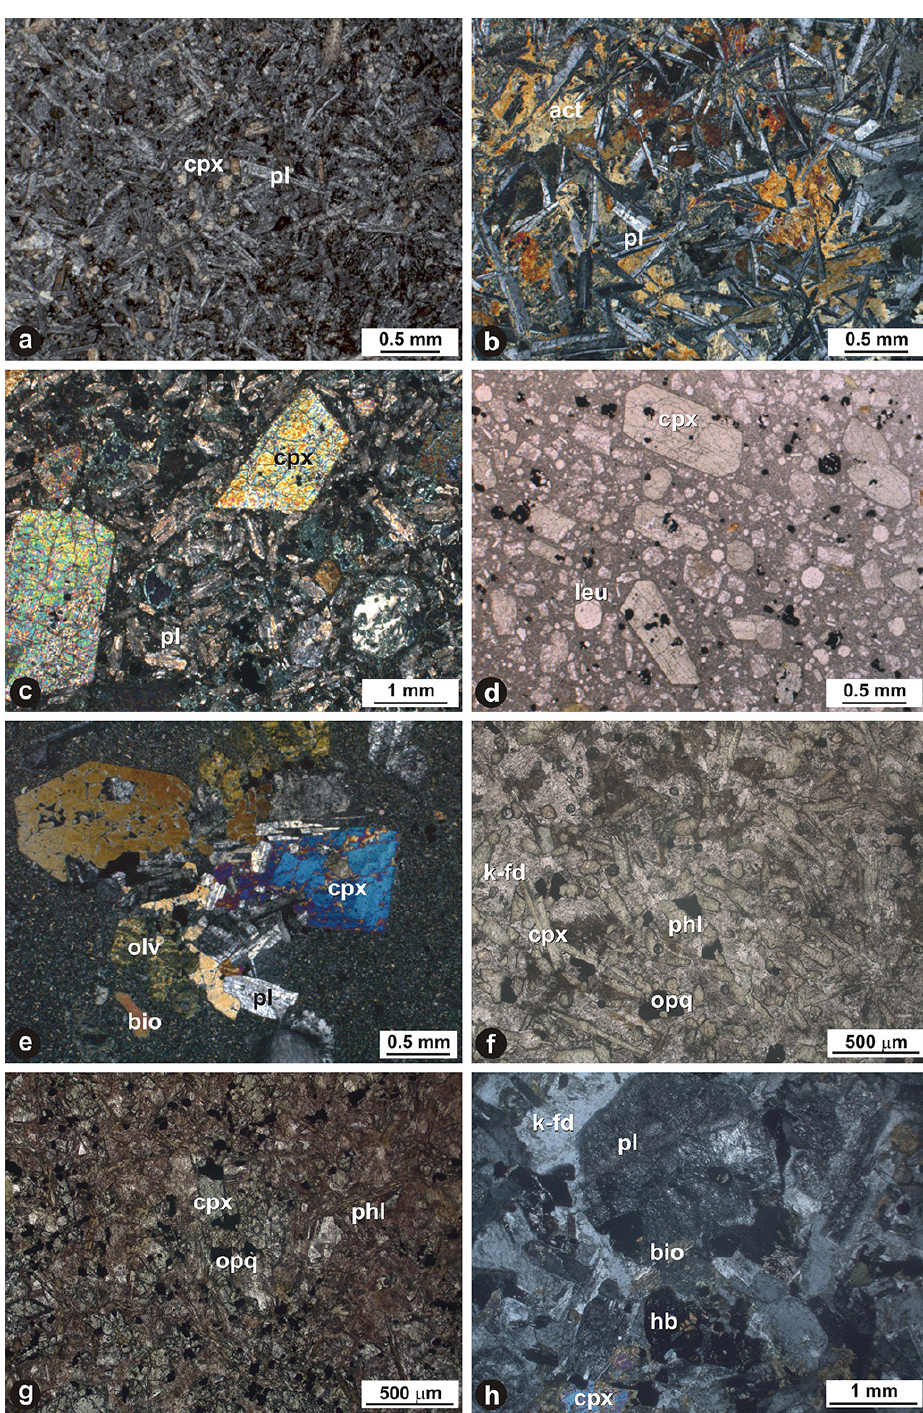
Fig. 12. Photomicrographs of (a) a seamount alkaline basalt sample. (b) Doleritic dike rock of the 180Ma Neotethyan oceanic crust. (c) Island arc alkaline basalt sample in cross-polarized light. (d) Island arc alkaline basalt sample in plane-polarized light. (e) Island arc basaltic andesite dike, showing a glomeroporphyritic texture. (f) Lamprophyric dike rock with small prismatic cpx (diopside) in a feldspar + phlogopite groundmass (plane-polarized light). (g) Lamprophyric dike rock with small prismatic cpx (diopside and phlogopite). (h) Syenodioritic pluton rock with plagioclase (altered to clay minerals) and biotite + hornblende and minor cpx (cross-polarized light).